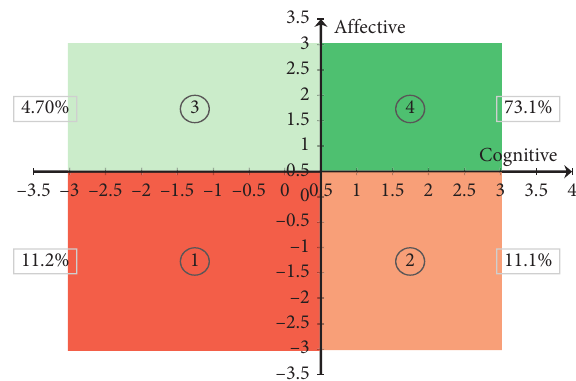
Figure 4: Correlation and inconsistence between cognitive and affective evaluation.